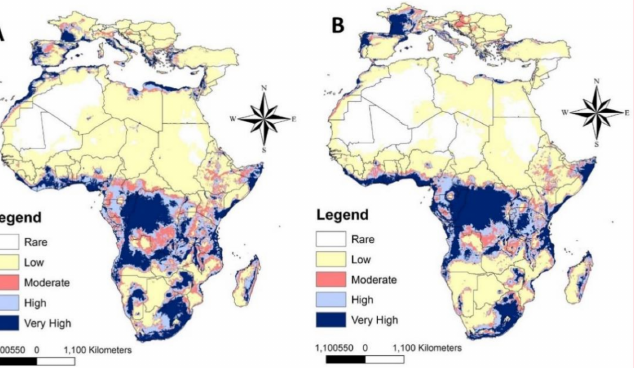
Figure 4. Predicted distribution of Oplostomus fuligineus in Africa and South Europe under future climate conditions in 2070; ( A ) for SSP 126, and ( B ) for SSP